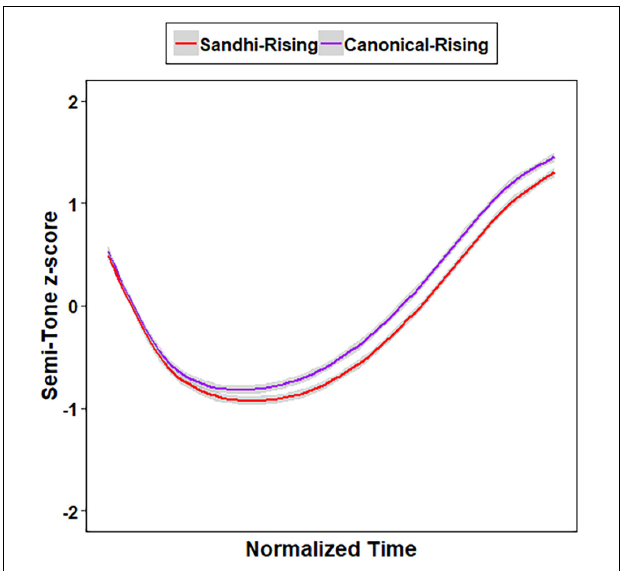
FIGURE 1 | Mean semi-tone z-scores of the Sandhi-Rising T3 and Canonical-Rising T2 syllables.